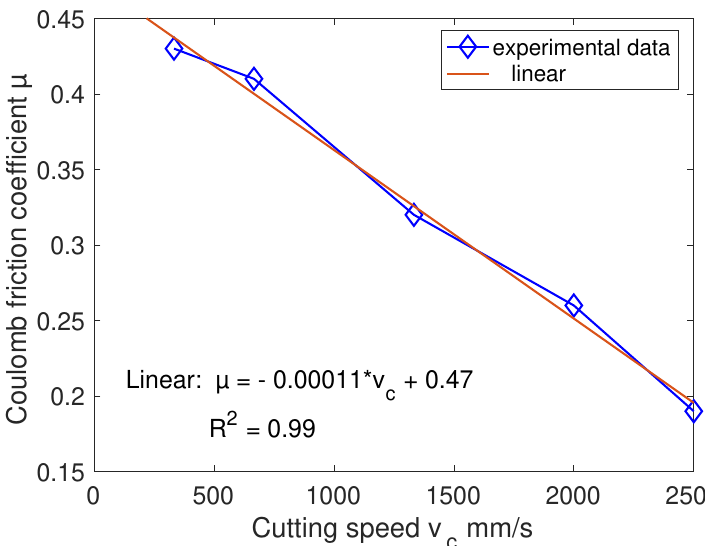
Figure 2. Description of Coulomb friction coefficient as a function of cutting speed based on [21].